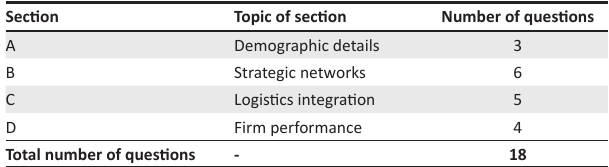
TABLE 1: Layout of the